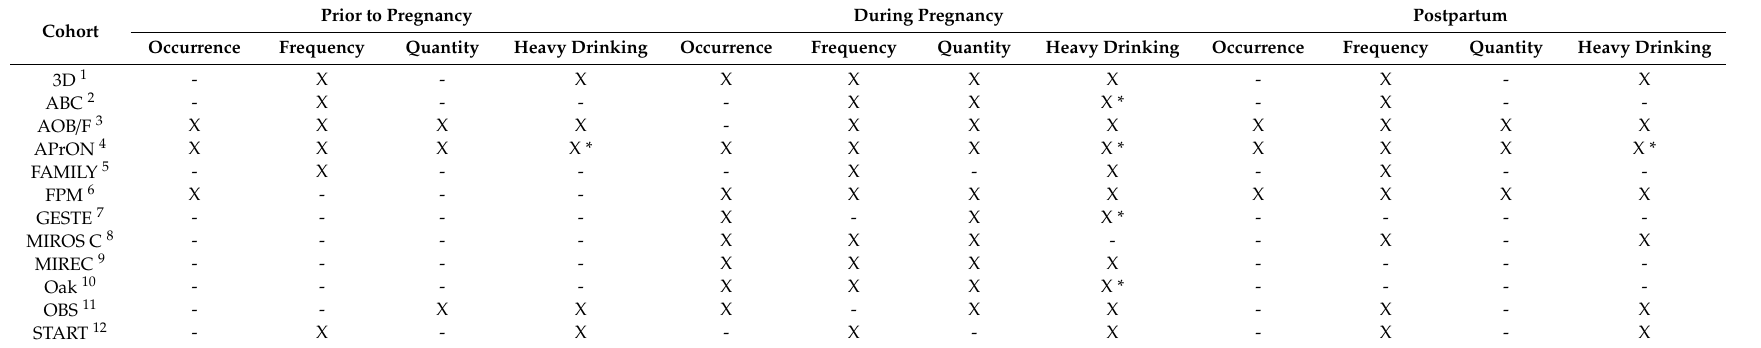
Table 1. Summary of information collected about alcohol use prior to, during and after pregnancy.